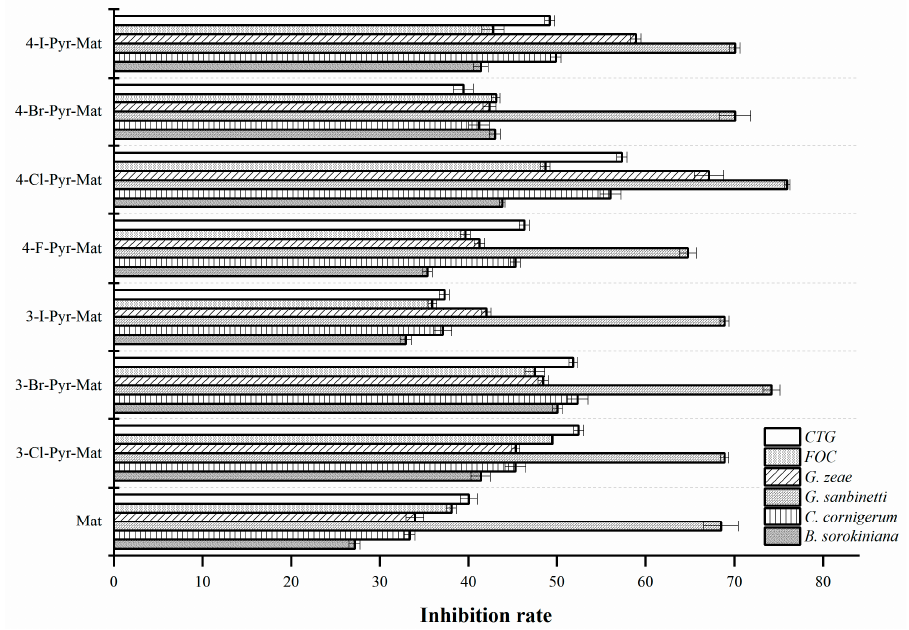
Figure 2. Fungicidal activities of matrine and its derivatives at concentration of 1.0 mg/mL.